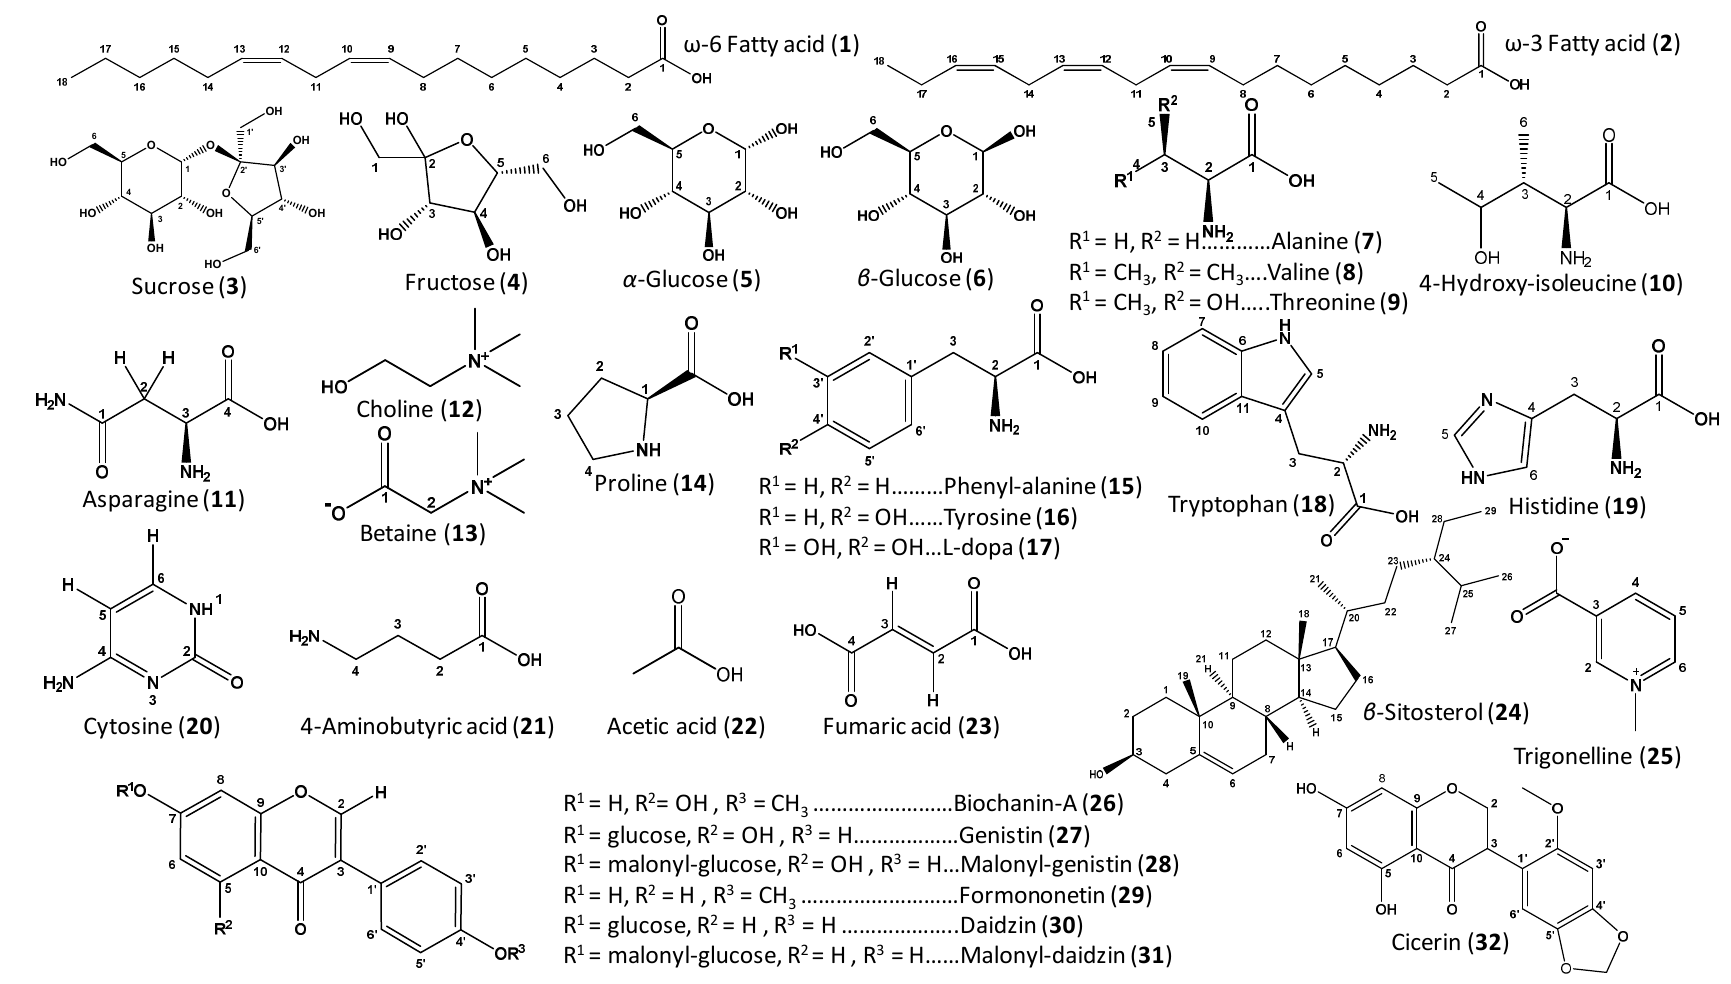
Figure 2. Structure of the major primary and secondary metabolites detected in chickpea, lentil, fenugreek, and fava sprout methanol extracts. Carbon numbering system for each compound is based on analogy rather than IUPAC rules. Metabolite numbers follow those listed in Table 1 for metabolite identification using 1D- and 2D-NMR.